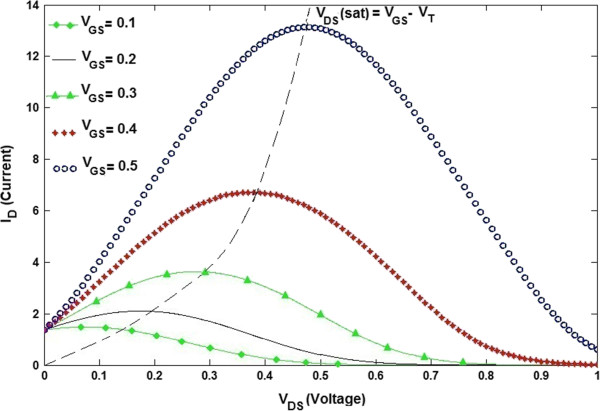
ID (μA)-VDS (V) characteristic of TGN SB FET at different values of VGS for L = 100 nm.